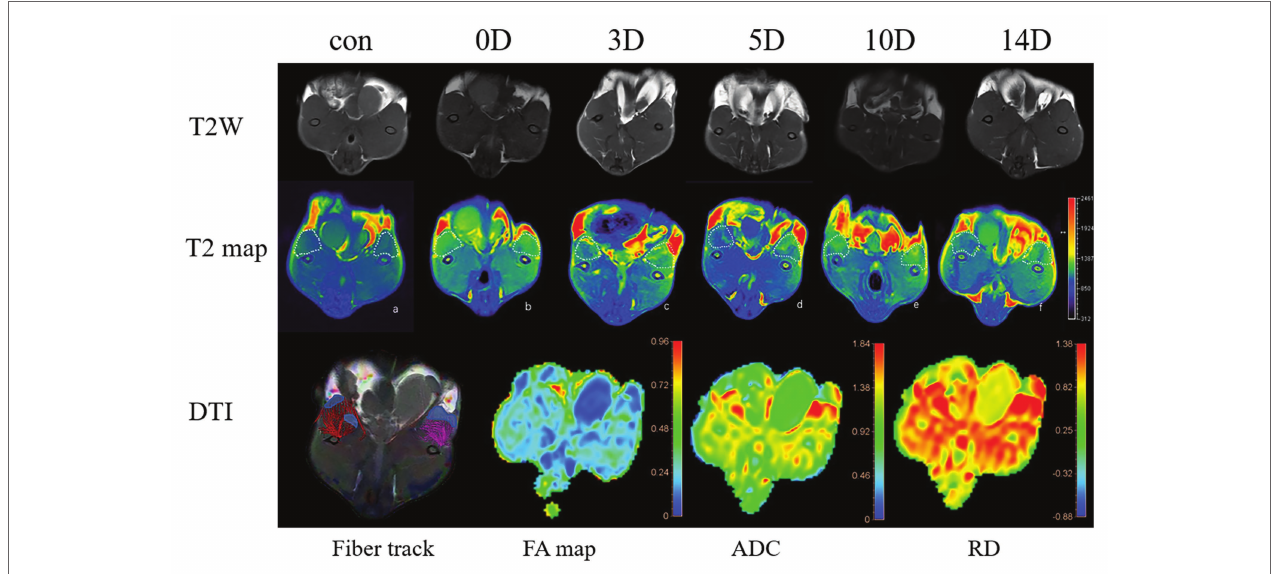
FIGURE 2 | T2WI, T2map axial sequence images in the (a-f) control group and frostbite group (0, 3, 5, 10, 14 days). The muscles in the ROI were manually drawn on the T2 map: the muscle in the control ROI is blue. The color of the ROI area changed significantly after frostbite. The diffusion tensor imaging (DTI) sequence: the schematic diagram of the fiber track of the DTI and the corresponding fractional anisotropy (FA) map, mean diffusivity (MD) map, and RD map. The area with fewer muscle fibers in the fiber track diagram is consistent with the high-signal area in the MD